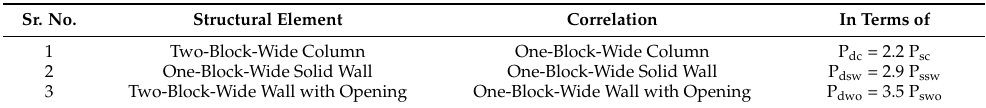
Table 3. Correlation between the load carrying capacities of one and two-block-wide structural elements.